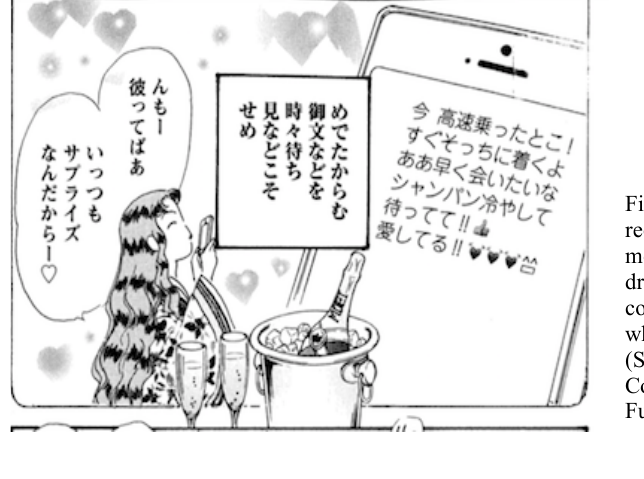
Figure 17. Heroine receives phone messages from her dream lover and cools champagne, while waiting for him (Shimizu 2014, 60). Courtesy of